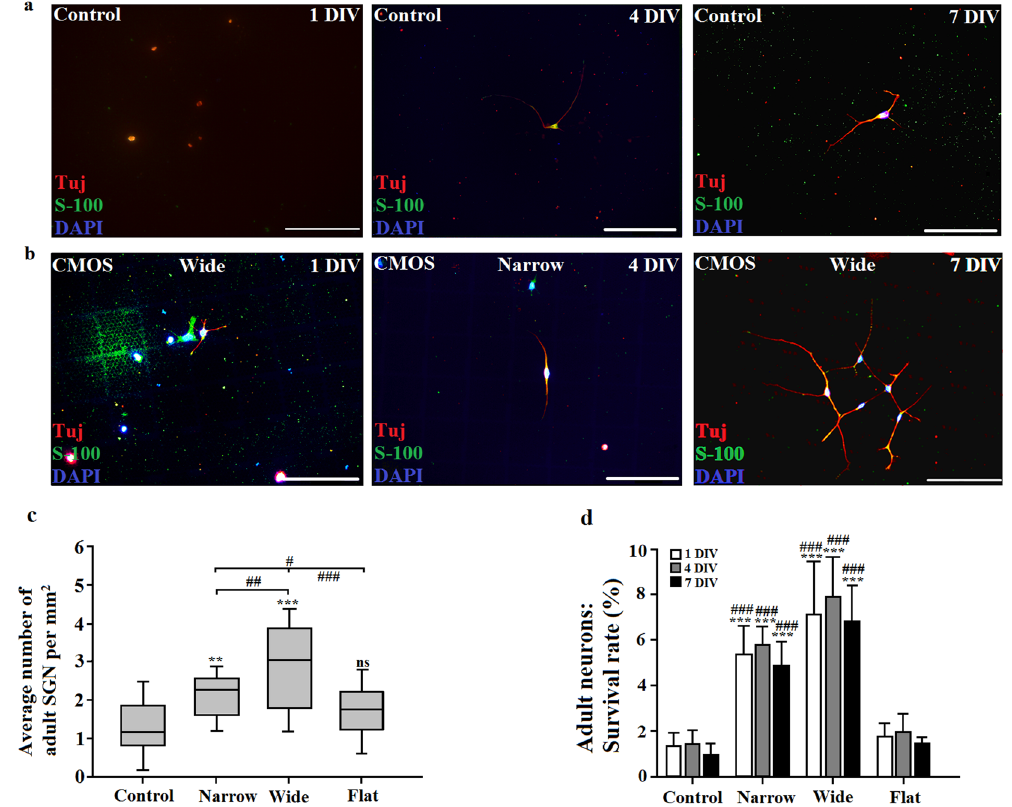
Figure 3. Presence of adult SGNs on glass coverslips (control) and CMOS chips. Cells were stained with the neuronal marker Tuj (red/magenta), the glial marker S-100 (green), as well as with the nuclear marker DAPI (blue). ( a ) Adult SGN on glass coverslips after 1 DIV, 4 DIV and 7 DIV. ( b ) Adult SGN on CMOS chips after 1 DIV, 4 DIV and 7 DIV. Scale bars: 200 µ m. ( c ) Box and whisker plots showing an effect of CMOS chips on adult SGN density. * indicates differences to control: ** P < 0.01, *** P < 0.001 and ns = not significant (one-way ANOVA, Tukey post-hoc test), # indicates differences between Narrow, Wide and Flat areas of the CMOS chip: # P < 0.05, ## P < 0.01 and ### P < 0.001 (one-way ANOVA, Tukey post-hoc test). ( d ) Survival rate (%) of adult SGN on CMOS substrates and control glass coverslips. * indicates differences to control: *** P < 0.001 (one-way ANOVA, Tukey post-hoc test) and # indicates differences between of Narrow and Wide areas to Flat areas of the chip: ### P < 0.001 (one-way ANOVA, Tukey post-hoc